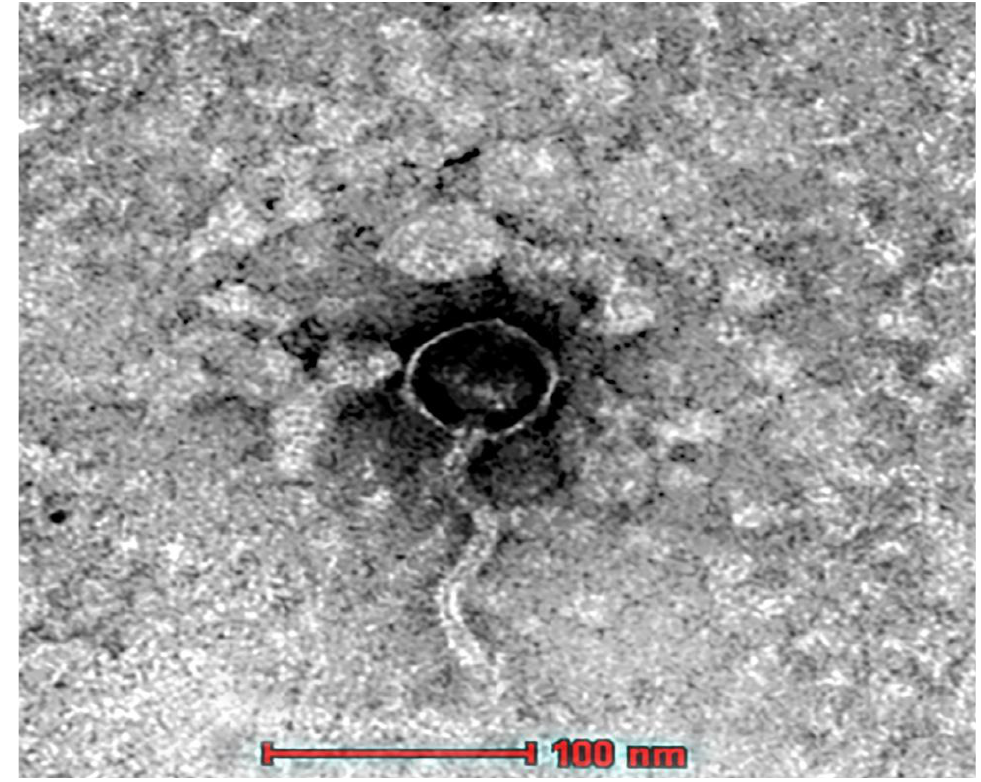
Figure 3. Transmission electron micrograph of the phage UAE_MI-01 phage. Scale bar = 100 nm.